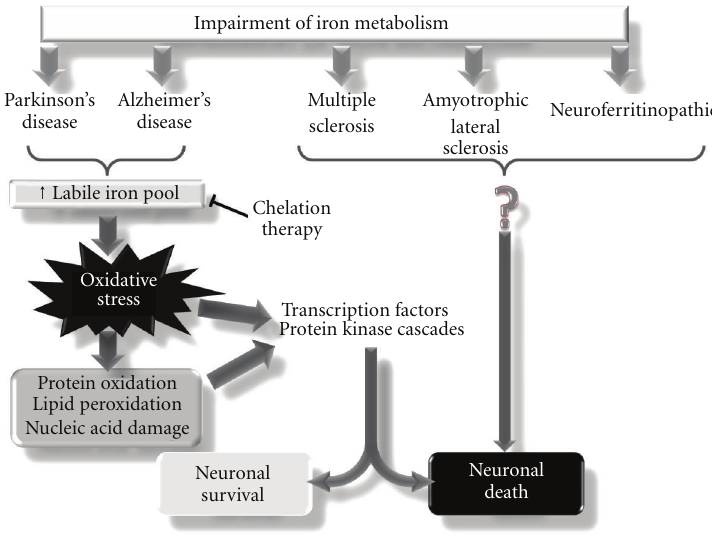
Figure 1: Relationship between the impairment of iron metabolism and neurodegenerative diseases. Impaired iron metabolism is a hallmark in several neurodegenerative diseases such as Parkinson’s (PD) and Alzheimer’s (AD) diseases, multiple sclerosis (MS), amyotrophic lateral sclerosis (ALS), and neuroferritinopathies. In the case of PD and AD, iron has been shown to play a key role in neuronal fate: depending on the extent and intensity of the oxidative stress caused by the increase in the labile iron pool, it a ff ects transcriptional activity and signaling cascades that could participate in neuronal survival or death. Although a role for iron has also been observed in MS, ALS, and neuroferritinopathies, the molecular events that lead to neuronal death are not fully